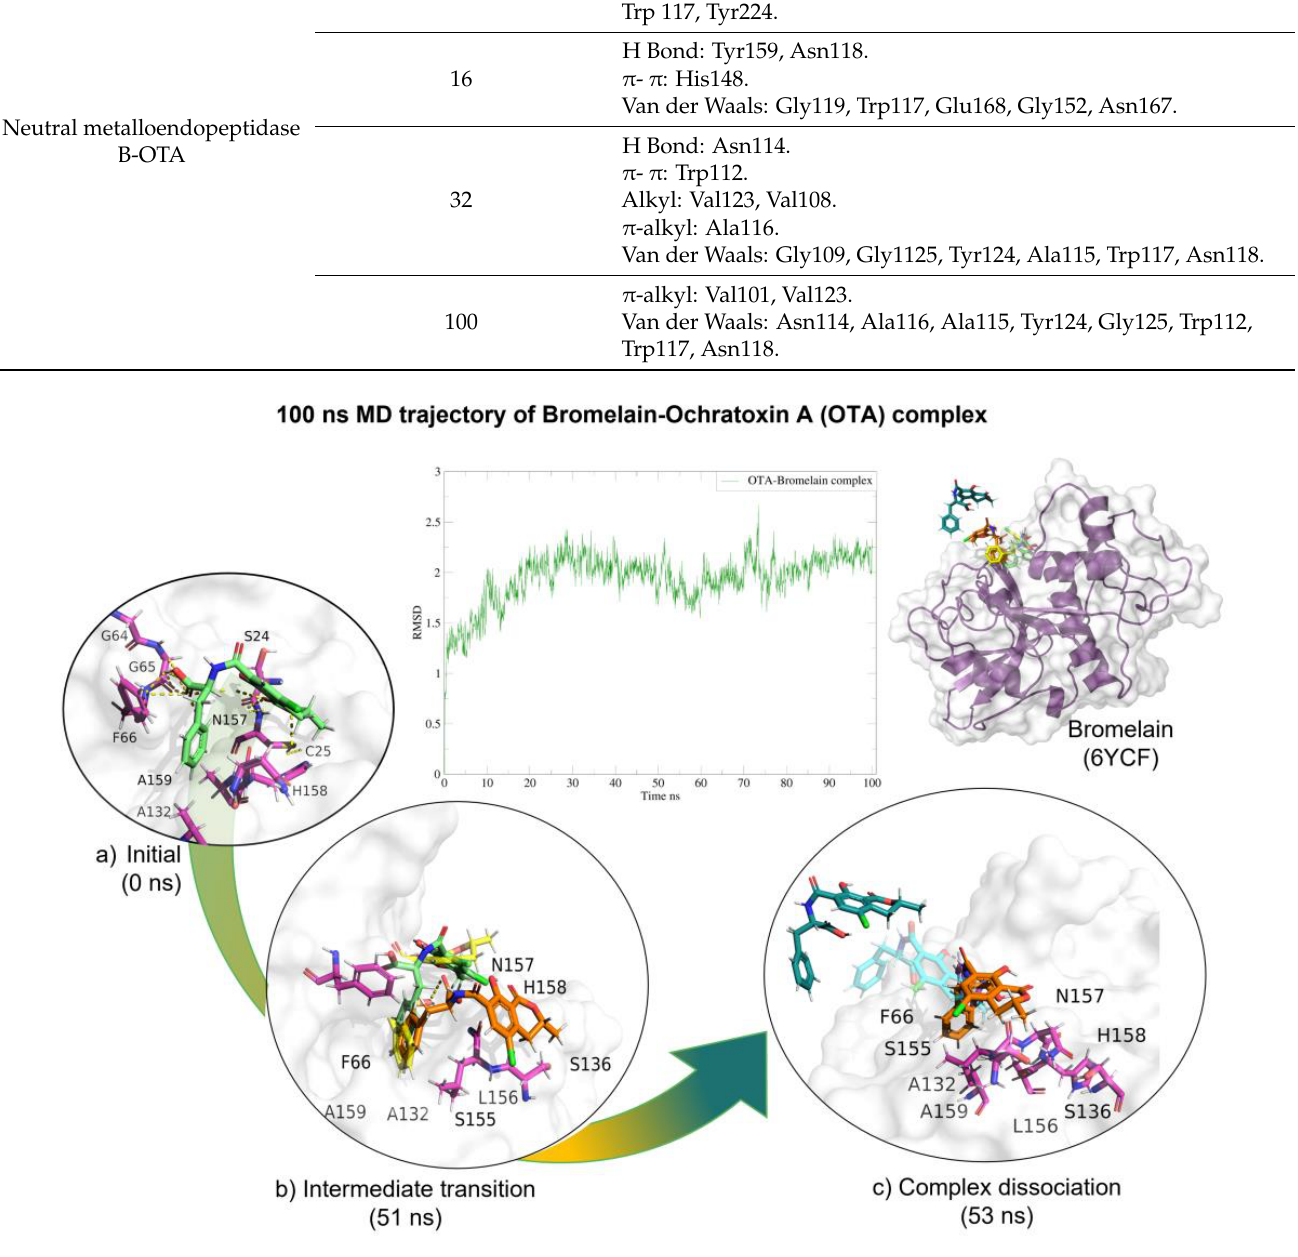
Figure 6. Molecular dynamics of the bromelain-OTA complex. The root mean squared deviation (RMSD) plot shows changes in the complex conformation with respect to the initial state during 100 (ns). ( a ) Initial pose (0 ns), complex initial state obtained from molecular docking studies. ( b ) Inter- mediate transition poses visualization where OTA moves within the ligand binding site. ( c ) Com- plex dissociation, OTA unbound from bromelain binding site. Green, OTA’s initial pose; Yellow, OTA at 31 (ns); Orange, OTA at 51 (ns); Blue, OTA at 52 (ns), Dark green, OTA at 53 (ns).